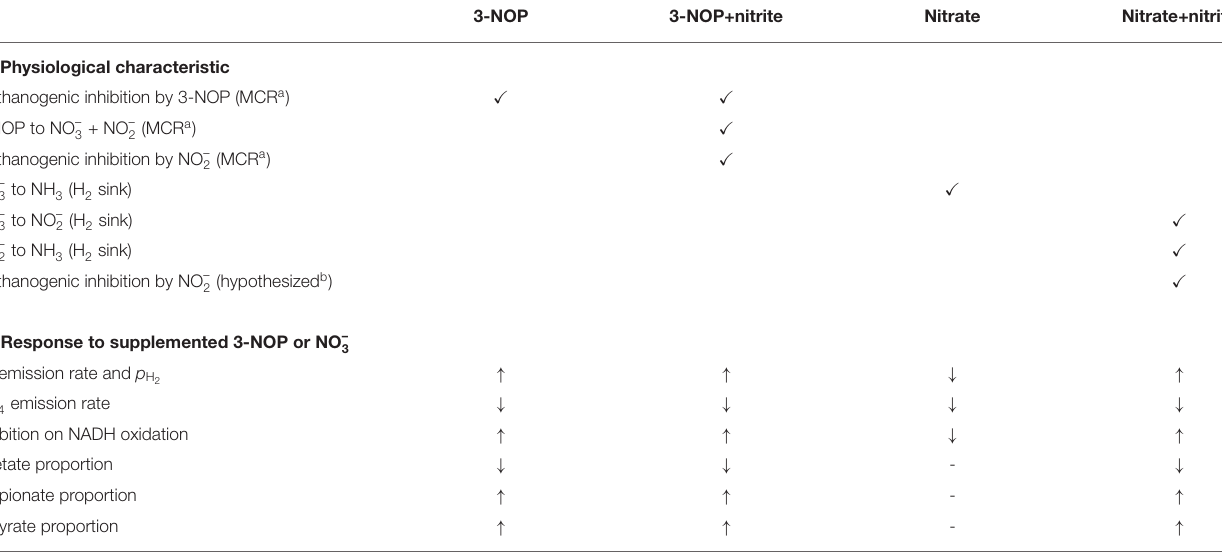
TABLE 1 | Overview of (A) physiological characteristics regarding methanogenic inhibition and H 2 sinks incorporated in 3-NOP, 3-NOP+nitrite, nitrate and nitrate+nitrite models, along with (B) the physiological response of various output variables to dietary inclusion of 3-NOP or NO – 3 . 3-NOP 3-NOP+nitrite Nitrate Nitrate+nitrite